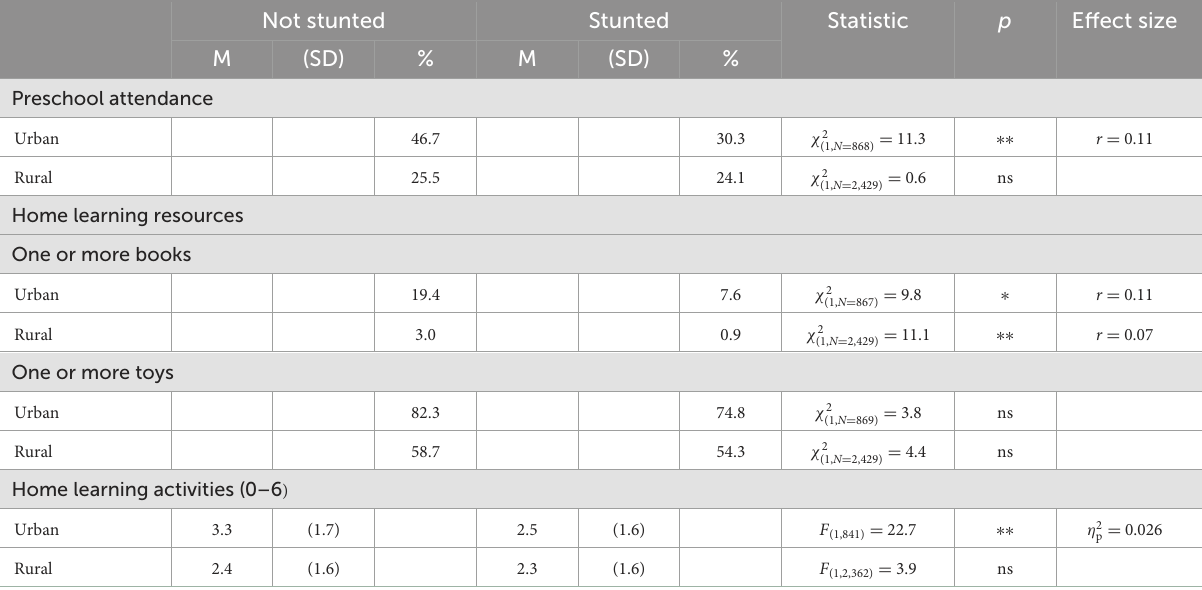
TABLE 4 Formal and informal learning opportunities for 36- to 60-month-old children in Côte d’Ivoire who were and were not stunted. Not